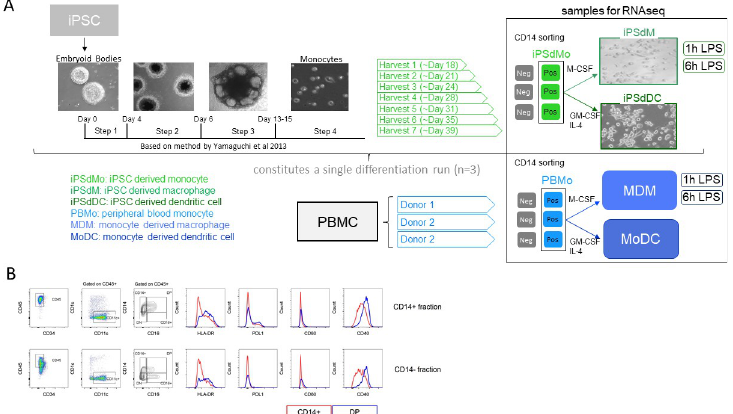
Fig 1. Generation of iPSC-derived monocyte, macrophages and dendritic cells and their comparison to blood derived counterparts. (A) Schematic illustrating the protocol and the samples generated including and used for downstream analysis. Also shown are representative images of the iPSC-derived cells both during the differentiation process and at terminal differentiation stages. (B) FACS analysis of the 2 fractions from the CD14 sorting step. Top row; CD14+ and bottom row; CD14- fractions respectively. Antibodies used are shown on the plots. Blue; CD16+ (DP; double positive) and red; CD16- fractions (CD14+).